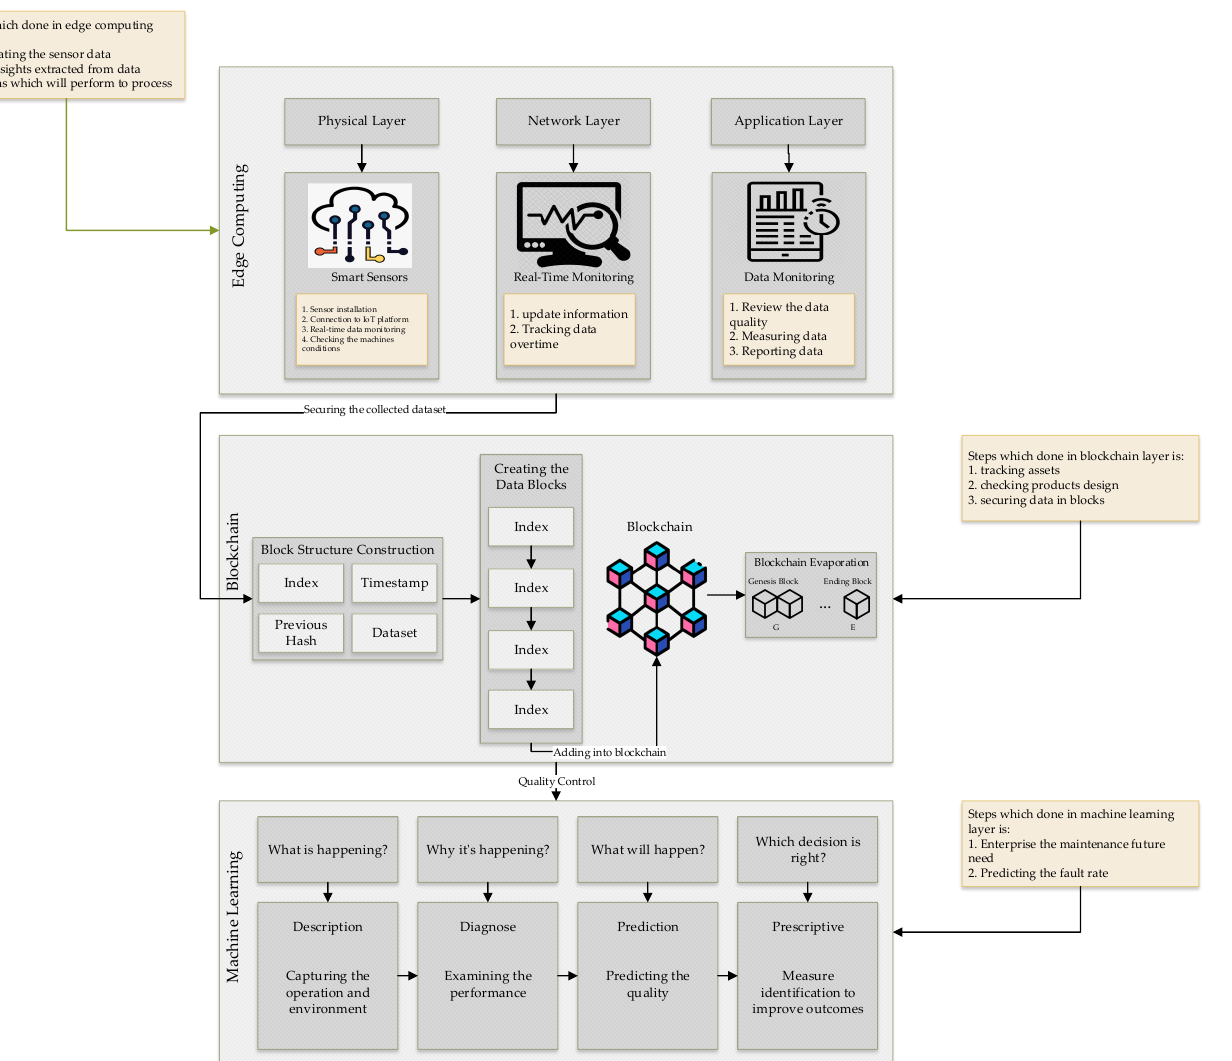
Figure 4. Smart manufacturing overall architecture based on an integrated